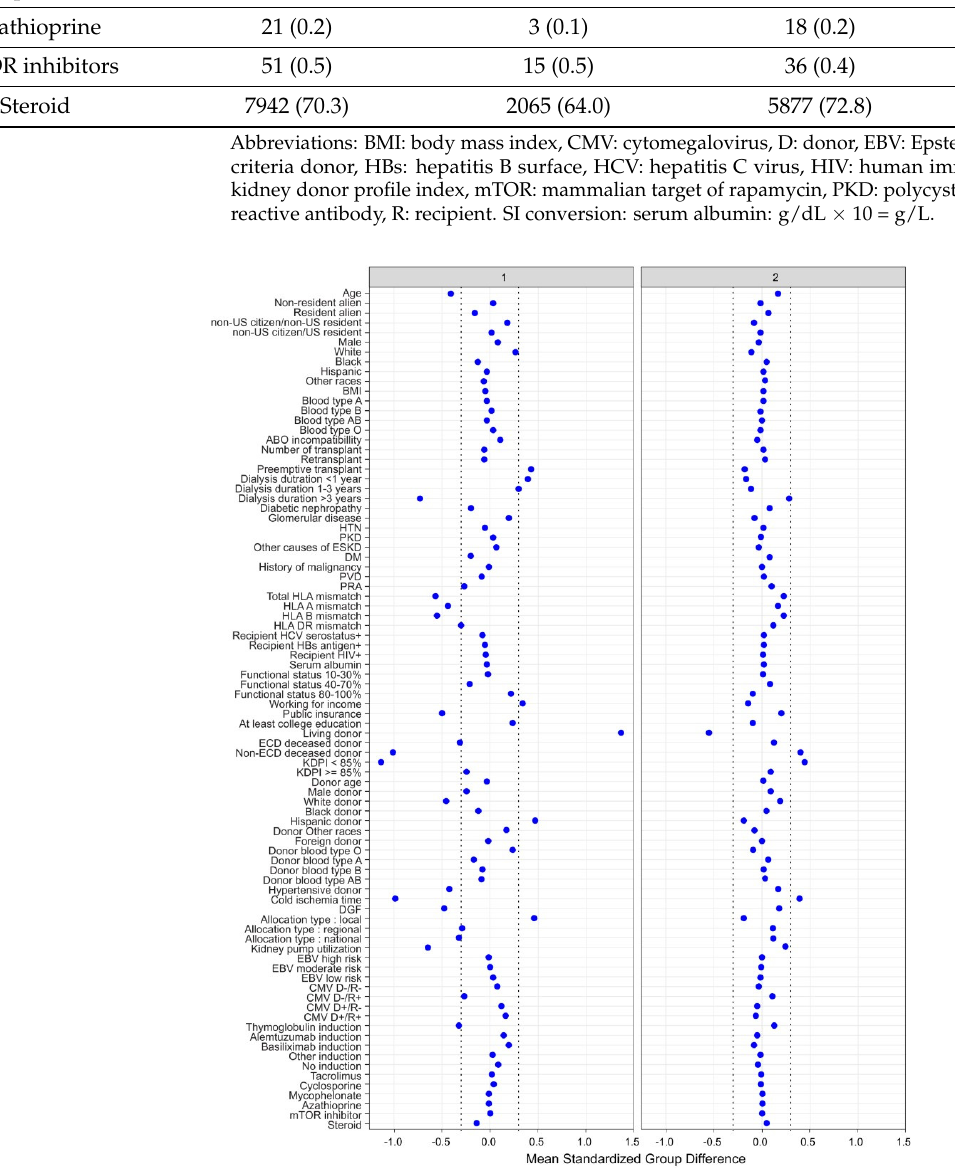
Figure 3. The standardized di ff erences across two clusters for each of the baseline parameters. The x axis is the standardized di ff erences value, and the y axis shows baseline parameters. The dashed vertical lines represent the standardized di ff erences cuto ff s of < − 0.3 or >0.3. Abbreviations: BMI: body mass index, CMV: cytomegalovirus, D: donor, DGF: delayed graft function, DM: diabetes mellitus, EBV: Epstein–Barr virus, ECD: extended criteria donor, ESKD: end stage kidney disease, GN: glomerulonephritis, HBs: hepatitis B surface, HCV: hepatitis C virus, HIV: human immunode- fi ciency virus, HLA: human leucocyte antigen, HTN: hypertension, KDPI: kidney donor pro fi le in- dex, mTOR: mammalian target of rapamycin, PKD: polycystic kidney disease, PRA: panel reactive antibody, PVD: peripheral vascular disease, R: recipient.